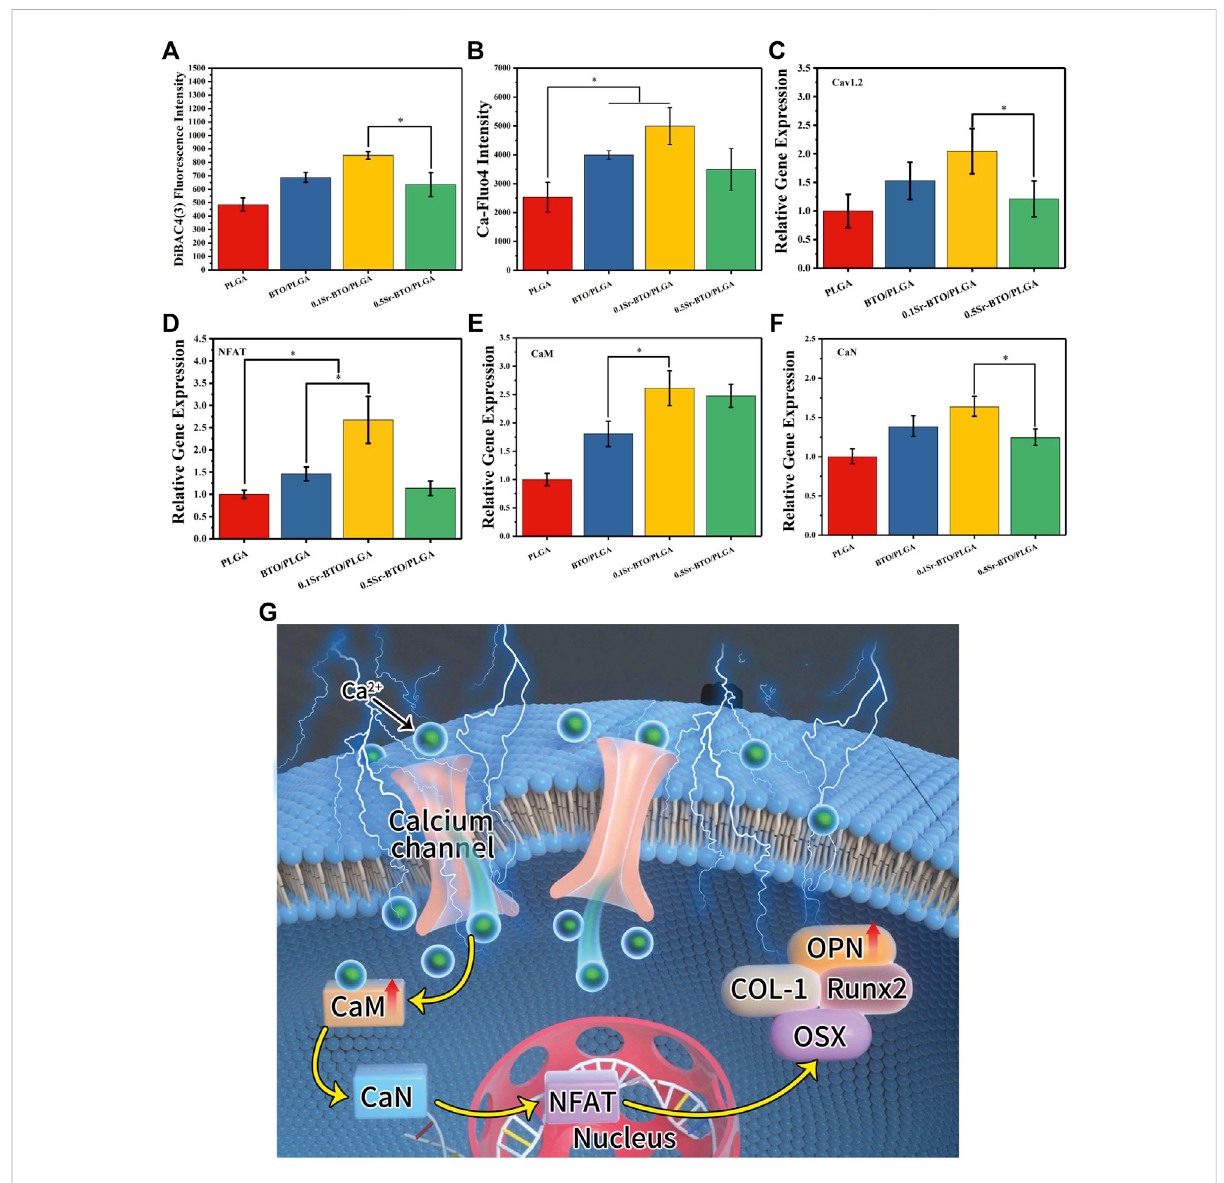
FIGURE 9 (A,B) Cell membrane potential and fl uorescence intensity of the Ca-Fluo-4 complex for PLGA, BTO/PLGA and Sr-BTO/PLGA microspheres at 1 day.RT-PCRresultsofMC3T3-E1culturedondifferentmicrospheresfor7 days:relativegeneexpressionlevelsof (C) Cav1.2, (D) NFAT, (E) CaM, (F) CaN; GADPH was used as a reference gene . * p < 0.05 (G) Schematic diagram of osteogenic differentiation of cell on